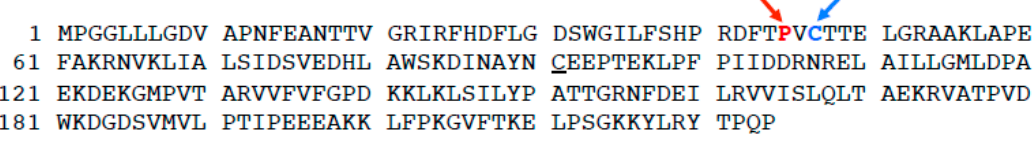
Figure 3. Amino acid sequence of human Prx6 protein molecule. Proline 45 (Pro45) and catalytic cysteine 47 (Cys47) are indicated by arrows.